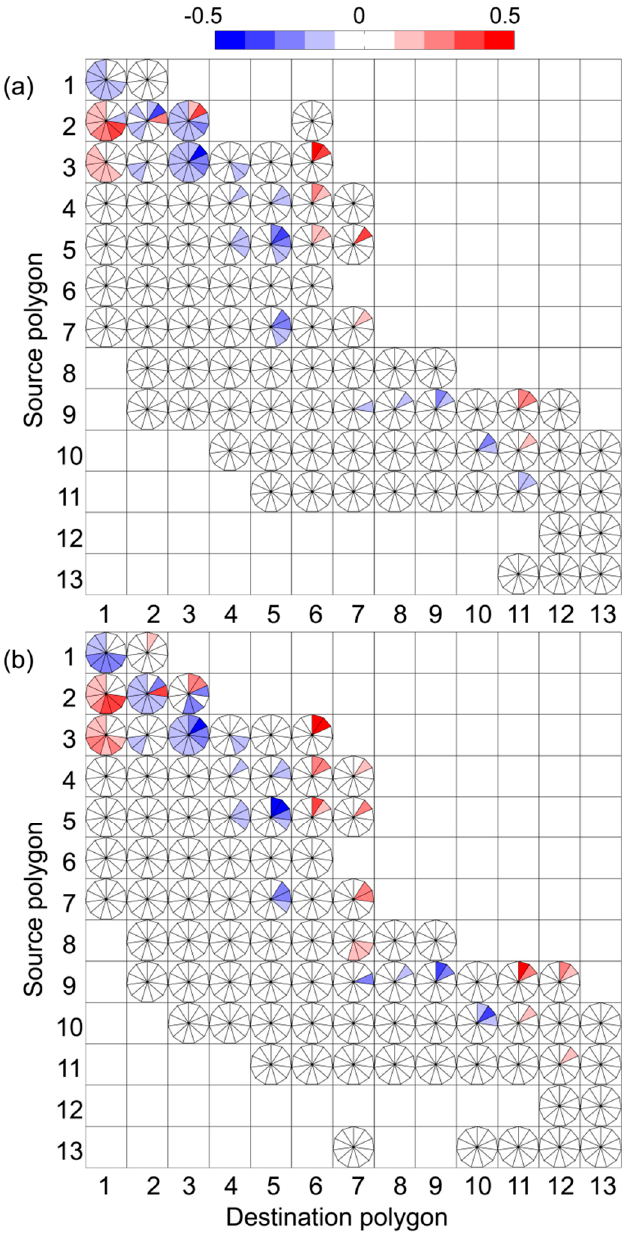
Figure 6. ( a ) DRCM clam-nuetral showing the change in connectivity when clam behavior is used instead of neutral particles, and ( b ) DRCM oyster-nuetral when oyster behavior is used. Positive and negative values indicate positive (red) and negative (blue) connectivity differences between particles with behavior (clam or oyster) subtracted from particles with neutral behavior.